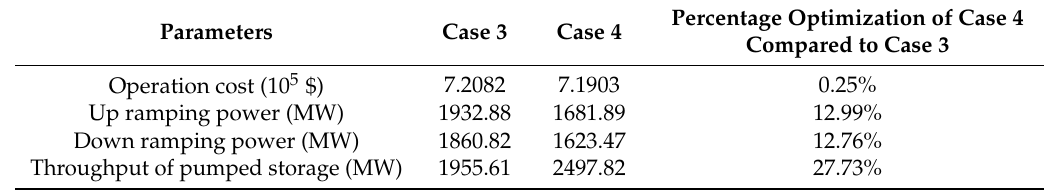
Table 5. Results comparison of Case 3 and Case